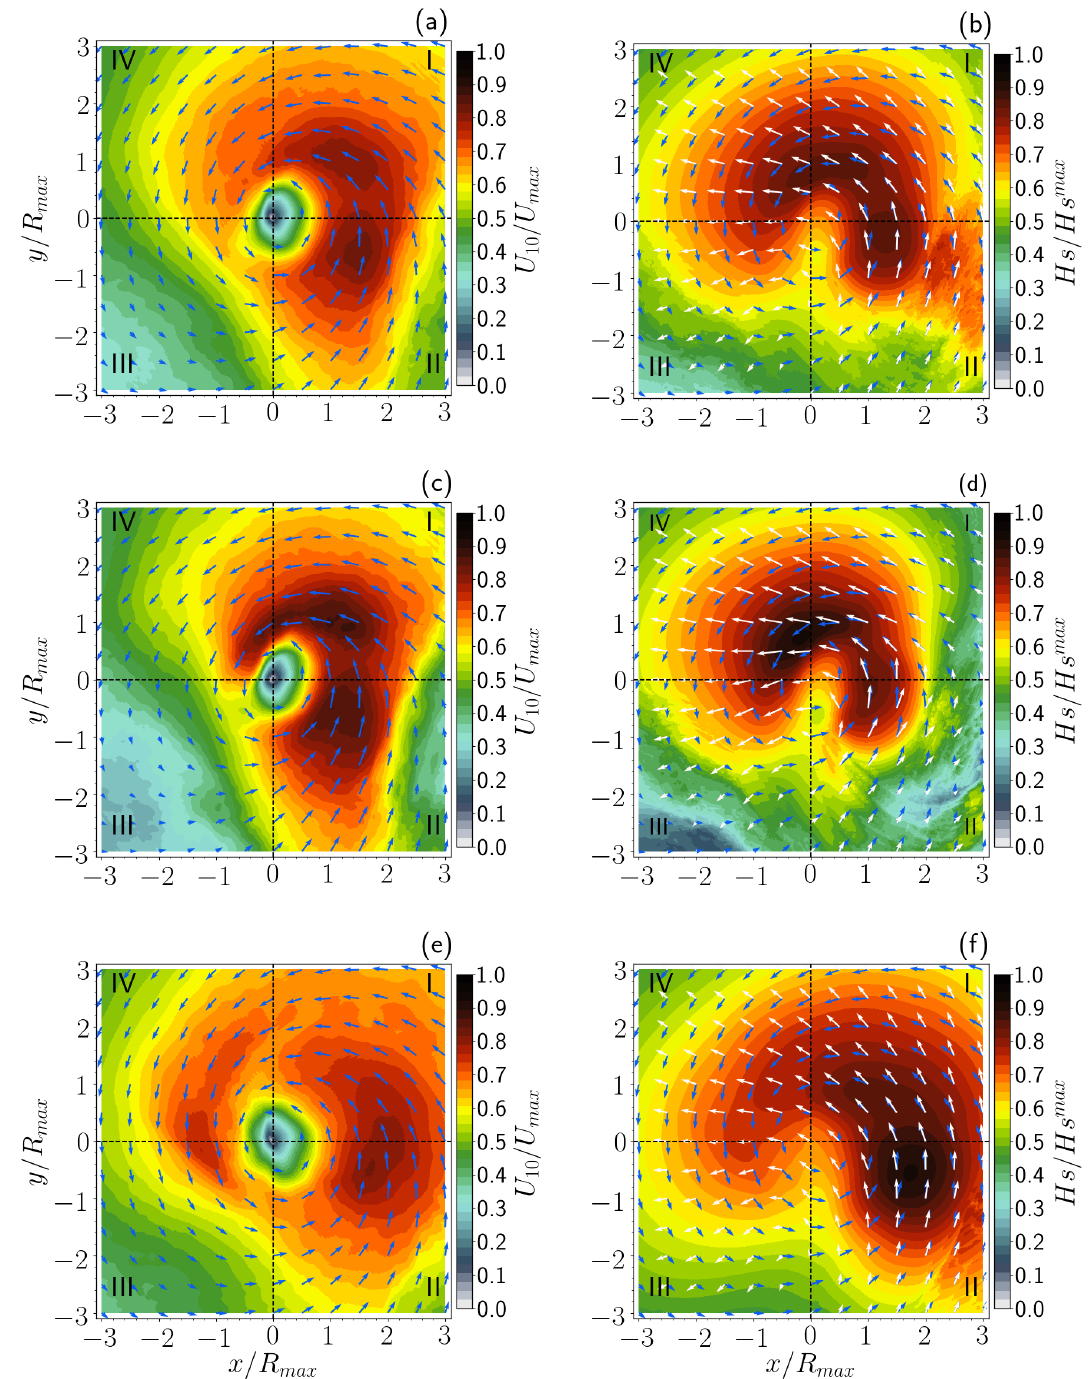
Figure 4. Wind fields ( left ) and mean significant wave height ( right ) obtained with original data. U 10 ( a ) and Hs ( b ) fields with an 18 h interval. Wind field ( c ) and significant wave height ( d ) for the moderate storm stage. Intensification stage for the wind field ( e ) and significant wave height ( f